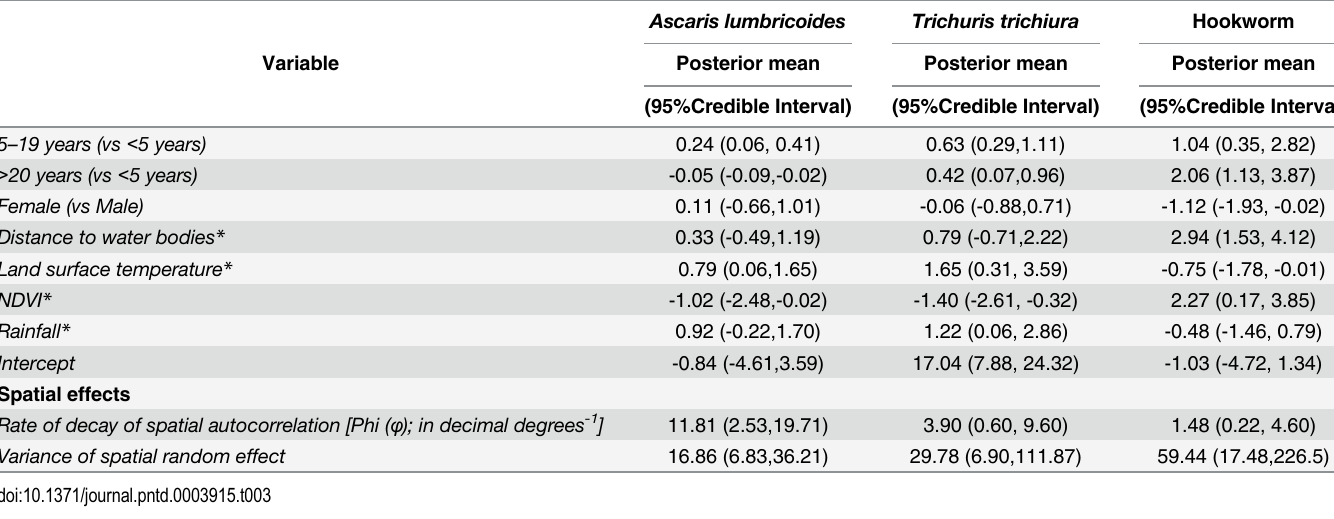
Table 3. Results of model parameters (in the log odds scale) for STH prevalence in Mindanao, Philippines, based on Bayesian geostatistical logis- tic regression